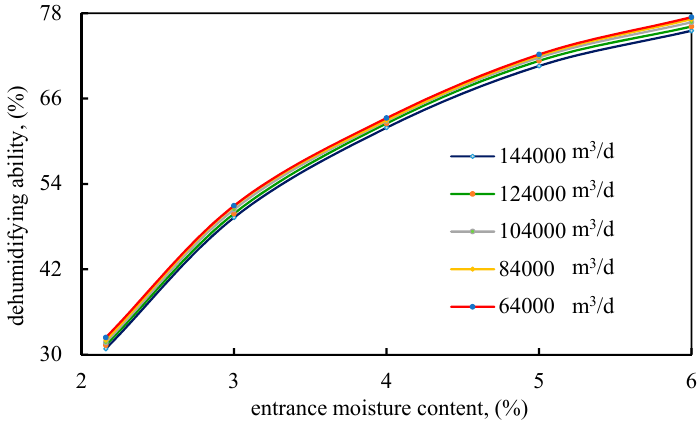
Figure 12. Varying patterns of dehumidification efficiency under different entrance velocities (before and after improving).